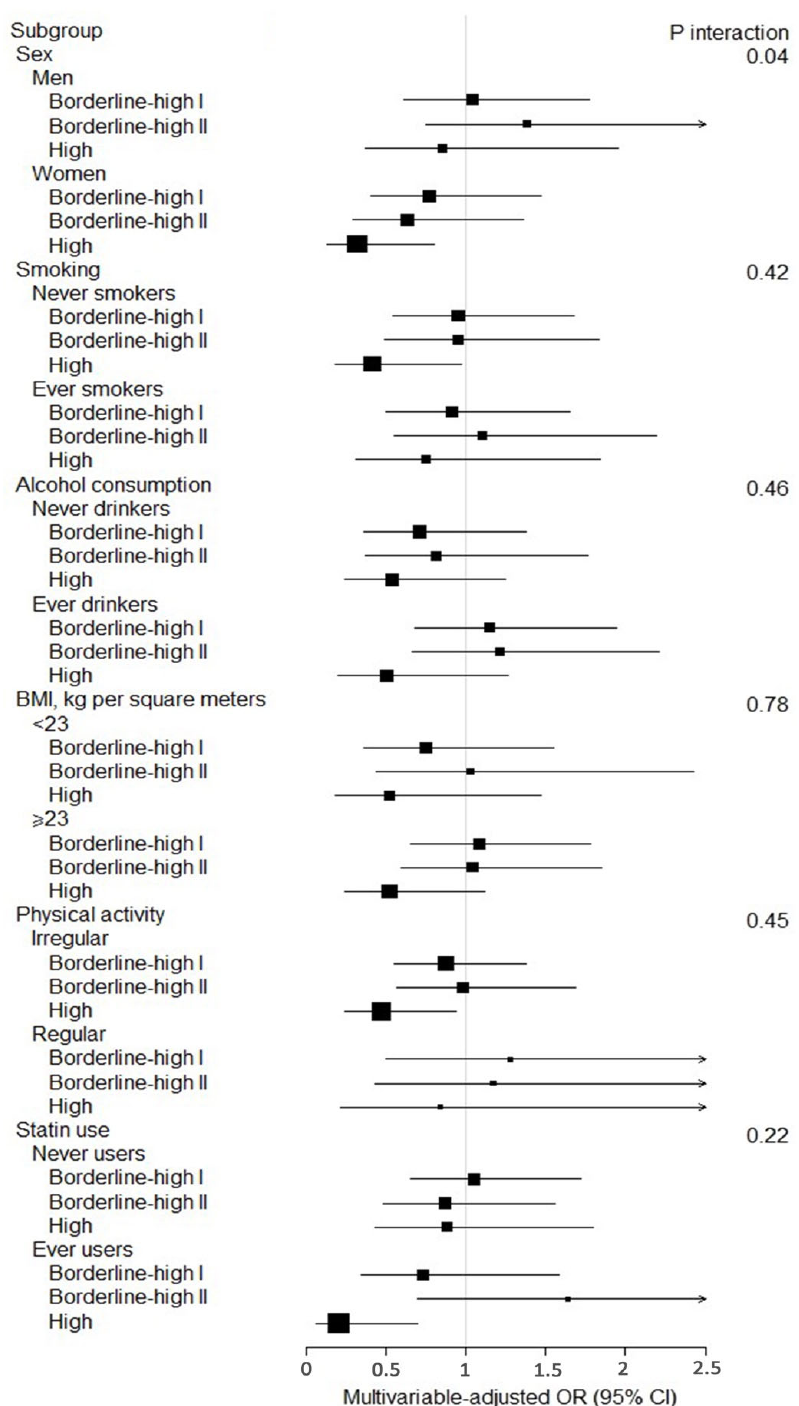
Figure 1. Multivariable odds ratios and 95% confidence intervals (CI) of pancreatic cancer for recent (–3 to 0 years) total cholesterol levels among subgroups, comparing borderline-high I, II, and high to desire cholesterol level. Adjusted for age (continuous, years), sex (men, women), body mass index (BMI) (<23, 23.0–27.4, ≥ 27.5 kg/m 2 ), smoking status (never smoker, ever smoker), regular physical activity (yes, no), alcohol drinking (yes, no), and stain use (yes, no), except for the stratifying factor defining the subgroup. Abbreviation: OR = odds ratio.